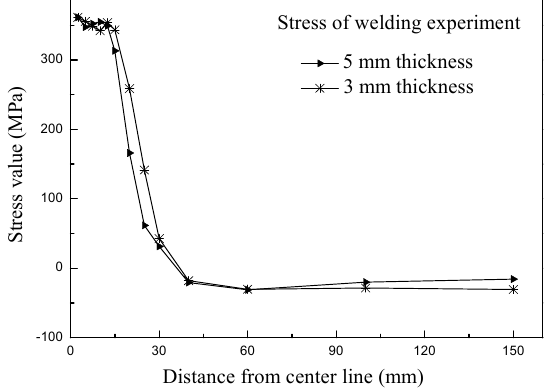
Figure 5. The longitudinal residual stress ( y -direction) after welding experiments: 3 mm thickness (Plate No. 3) and 5 mm thickness (Plate No. 6).